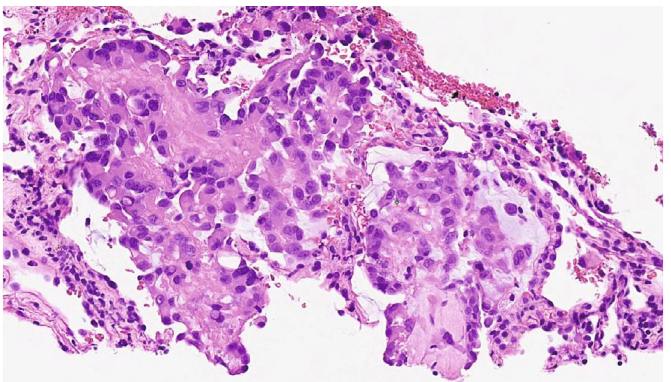
Figure 3: Hematoxylin and eosin stain of transthoracic needle lung biopsy. This slide is at 40x magni fi cation. The sections show multiple cores of lung parenchyma, some of which contain an intra-alveolar in fi ltrate of relatively monomorphic tumor cells with round nuclei and a moderate eosinophilic cytoplasm. The cells are set in a myxohyaline stroma. Scattered areas show intracytoplasmic lumina, and there are also intranuclear inclusions. Most of the tumor appears to be intra-alveolar and the surrounding lung parenchyma shows mildly prominent type II pneumocytes. There is no evidence of signi fi cant nuclear atypia, mitoses, or necrosis.